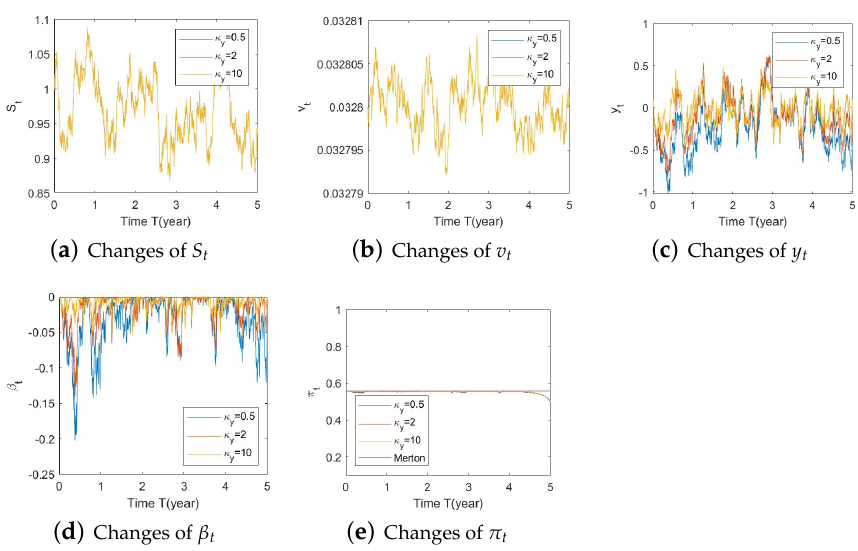
Figure A7. Illustrate the impact on ( a ) stock prices, ( b ) driver of volatility, ( c ) driver of elasticity, ( d ) elasticity of volatility, and ( e ) optimal stock allocations when varying the speed of reversion, κ y ( e . g ., κ y = 0.5,2,10 )